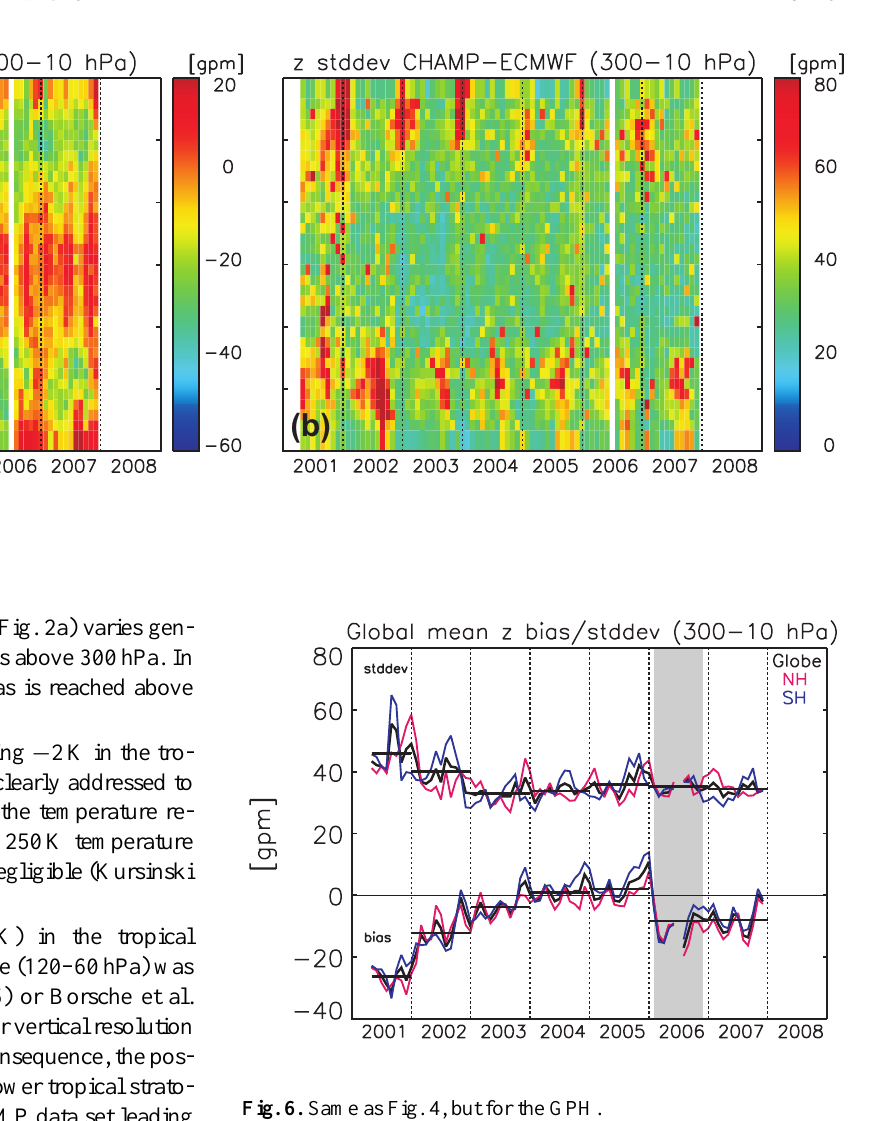
Fig. 6. Same as Fig. 4, but for the